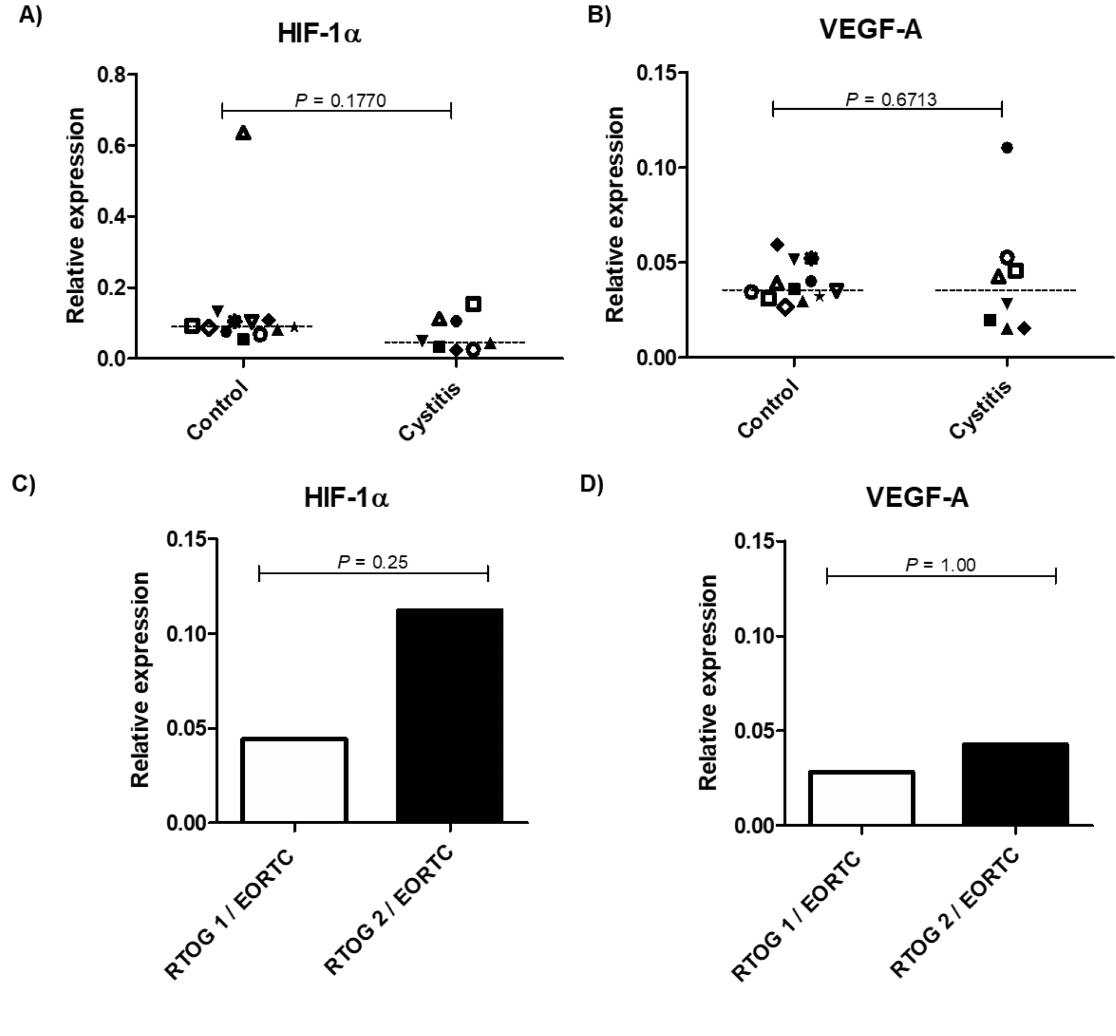
Figure 3 - Droplet digital PCR expression analysis of HIF-1 α and VEGF-A mRNA. (A) and (B) Analysis of HIF-1 α and VEGF-A mRNA in non-irradiated patients (control) and patients previously submitted to pelvic radiotherapy (cystitis). (C) and (D) Analysis of HIF-1 α and VEGF-A mRNA expression in patients previously submitted to pelvic radiotherapy according to the late RTOG/EORTC morbidity score. (E) and (F) Analysis of HIF-1 α and VEGF-A mRNA in bladder tissue samples and washing bladder samples of non-irradiated patients. The targets mRNA expression were calculated relative to a stable expressed reference gene (GAPDH). Results were expressed as median and comparison between groups was performed by Mann– Whitney U test. RTOG/EORTC: grade 1 - mild epithelial atrophy, small telangiectasia (microscopic hematuria); grade 2 - moderate frequency, generalized telangiectasia, and intermittent macroscopic